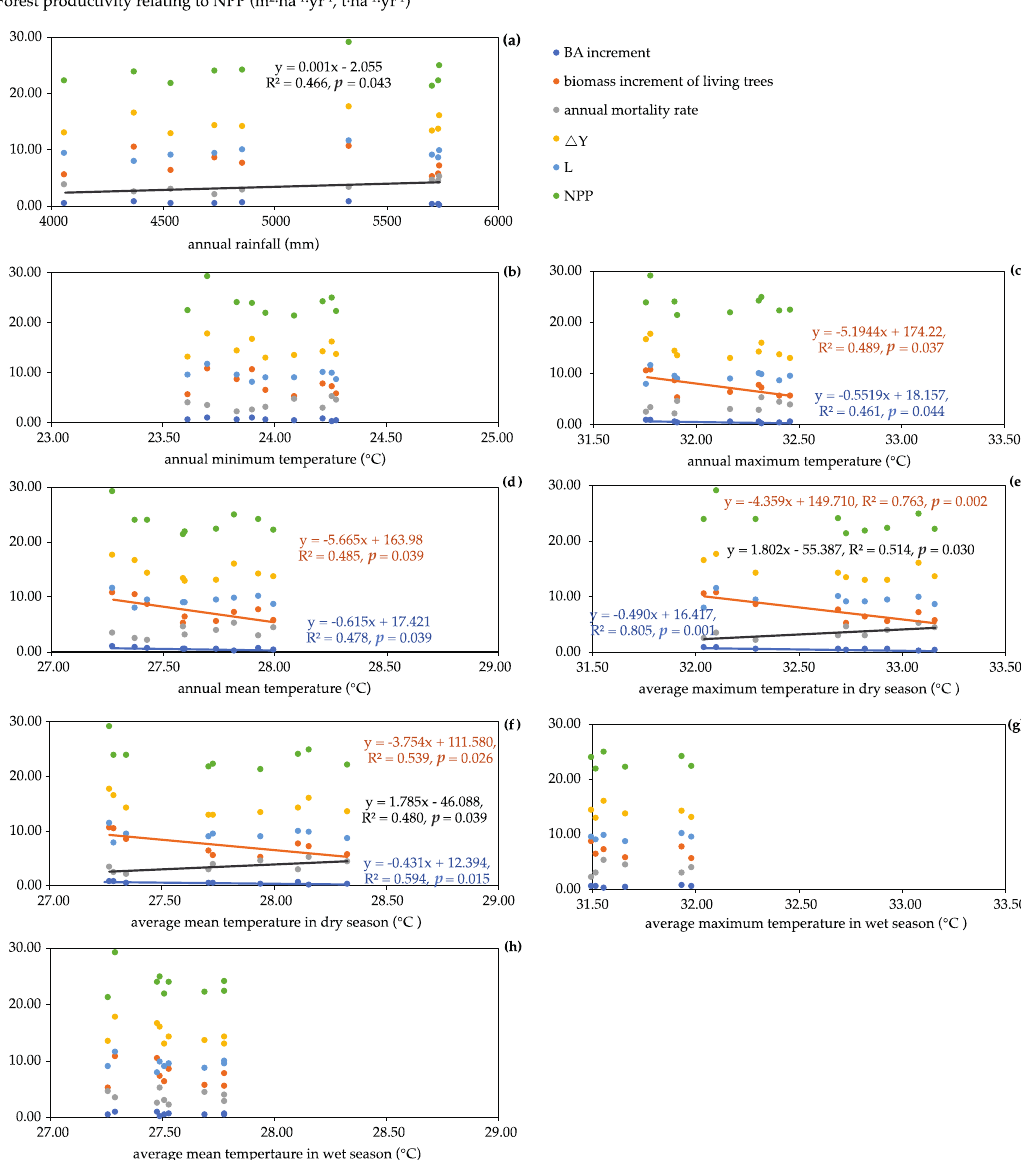
Figure 6. Linear regression models between the parameters relating to NPP (namely; basal area increment, m 2 · ha − 1 · yr − 1 ; biomass increment of living trees, t · ha − 1 · yr − 1 ; annual mortality rate, t · ha − 1 · yr − 1 ; ∆ Y, t · ha − 1 · yr − 1 ; L, t · ha − 1 · yr − 1 ; and NPP, t · ha − 1 · yr − 1 ) and climatic factors, including annual rainfall ( a ), annual minimum temperature ( b ), annual maximum temperature ( c ), annual mean temperature ( d ), average maximum temperature in dry season ( e ), average mean temperature in dry season ( f ), average maximum temperature in wet season ( g ), and average mean temperature in wet season ( h ) from Y1 to Y9. Data without linear regression lines indicate models are not significant. The relationships and lines of the regression were shown for p < 0.05.